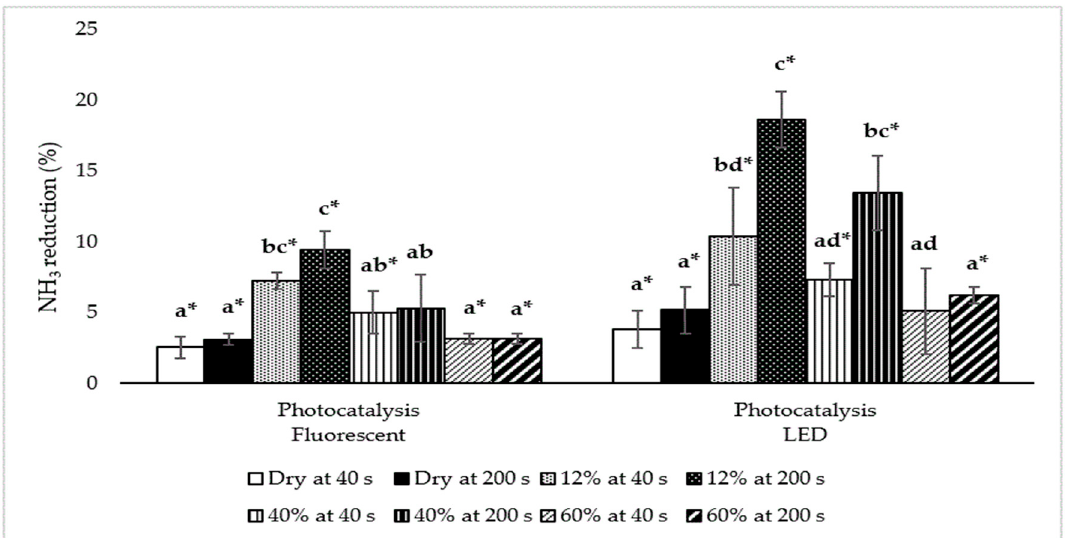
Figure 4. Comparison of NH 3 mitigation under different relative humidity and treatment time. Superscript (*) signifies a statistical difference compared to the control ( p < 0.05), and the different characters (a, b, c, d) signify the statistical difference between treatments associated with one UV lamp type ( p < 0.05). Error bars signify ± standard deviation.